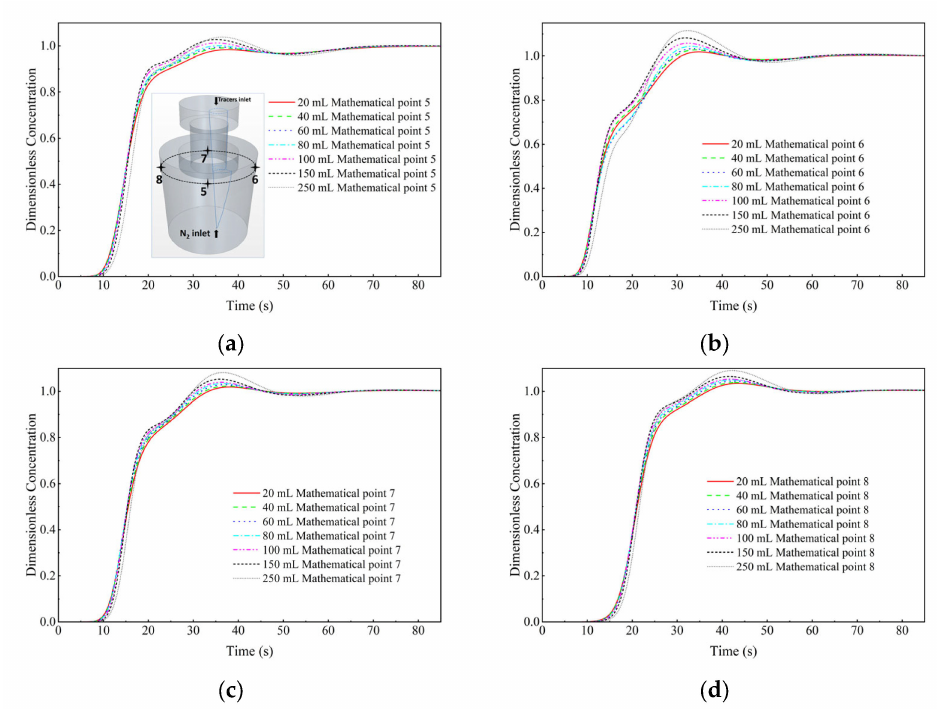
Figure 20. Comparison of the dimensionless concentration-time curves of the KCl solution cases with different dosages at different monitor locations. ( a ) Monitor point 5, ( b ) Monitor point 6, ( c ) Monitor point 7, and ( d ) Monitor point